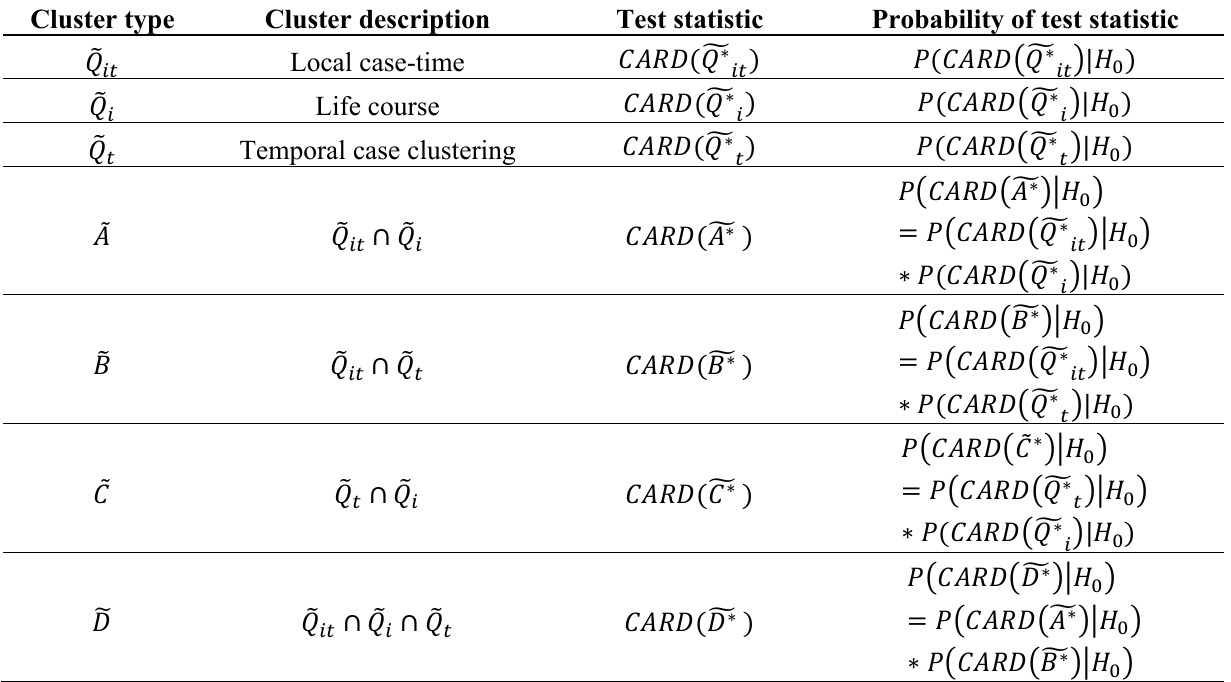
Table 2. Statistics to evaluate the overall significance of the cluster types in a manner that does not involve multiple